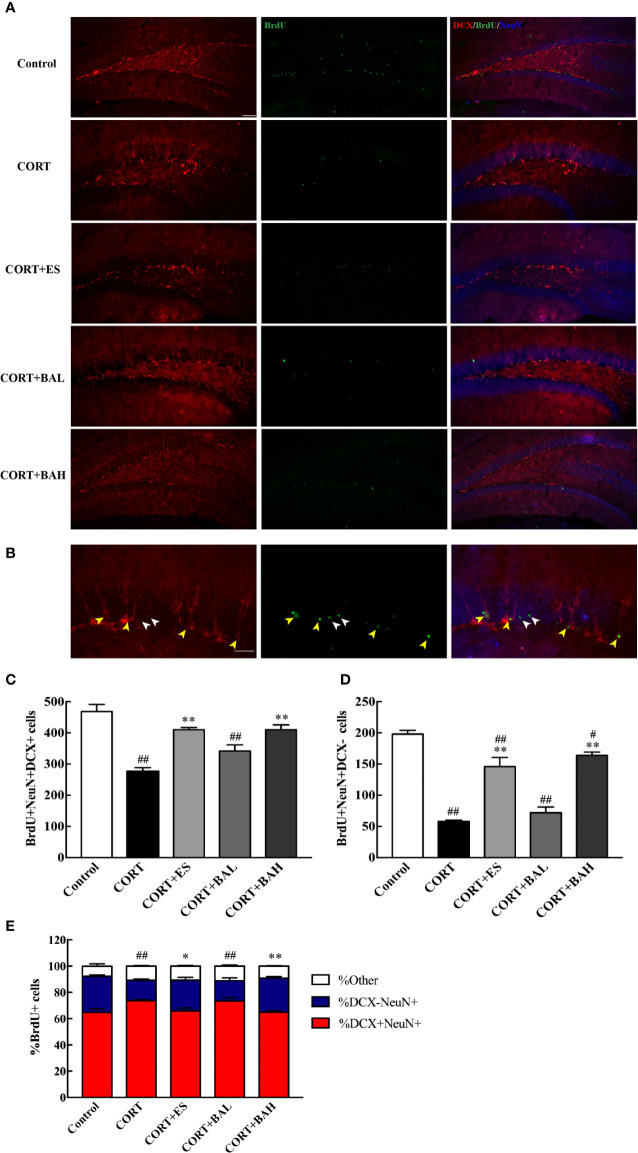
Baicalin promotes maturation of newborn granule cells in the dentate gyrus of chronic corticosterone (CORT)-induced depression model mice. (A) Hippocampal dentate gyrus (DG) images of the adult newborn neurons (red: DCX; green: BrdU; Blue: NeuN), scale bar=50 μm; (B) Enlarged images of the newborn immature neurons (morphology of DCX+/NeuN+/BrdU+ cells, yellow arrows) and the mature neurons (morphology of DCX-/NeuN+/BrdU+ cells, white arrows), scale bar=20 μm; (C) The number of the newborn immature neurons; (D) The number of adult born mature neurons; (E) The proportion of DCX-/NeuN+/BrdU+ cells (percentage of BrdU cells). The results are mean  ± SEM (n=3 mice/group). #P < 0 .05 and ##P < 0.01 versus Control, *P<0.05 and **P<0.01 versus CORT.